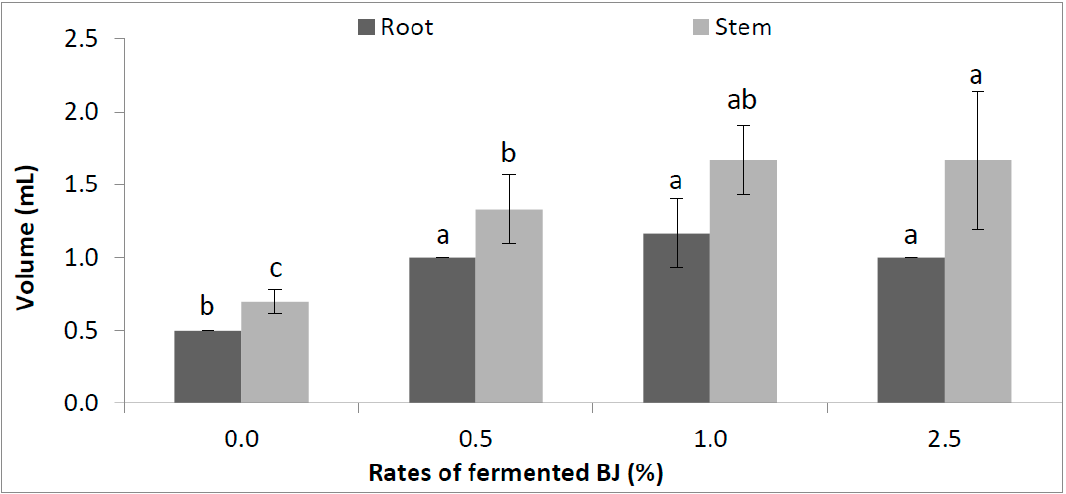
Figure 2. Stem and root volume of sweet basil plants treated with different rates of fermented BJ. Sample size n = 6 (mean ± SD). Different letters above the same columns show significant differences at the level of p ≤ 0.05.